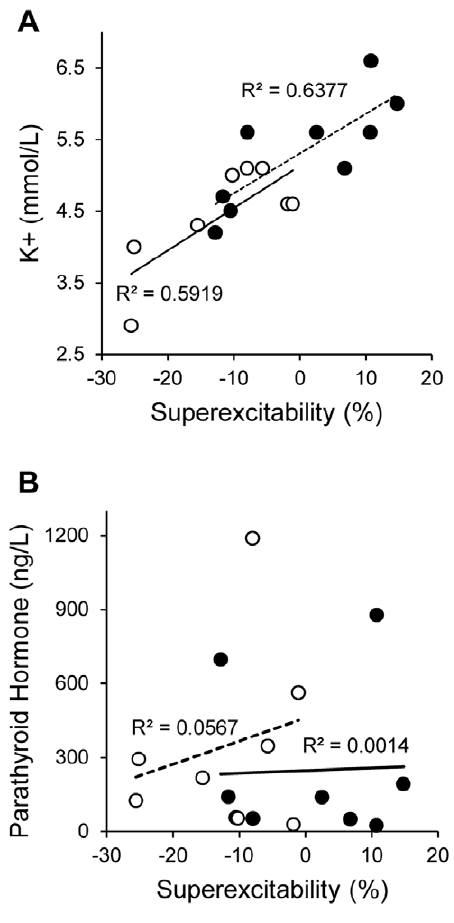
Figure 2. Relationship of pre-RRT bloods and superexcitability; a sensitive measure of membrane potential. (A) Pre-RRT serum K + concentrations for both HDF (empty circles) and HFHD (black filled circles) demonstrated multiple significant correlations with nerve excitability parameters including superexcitability. (B) In contrast pre- RRT serum parathyroid hormone concentrations showed no